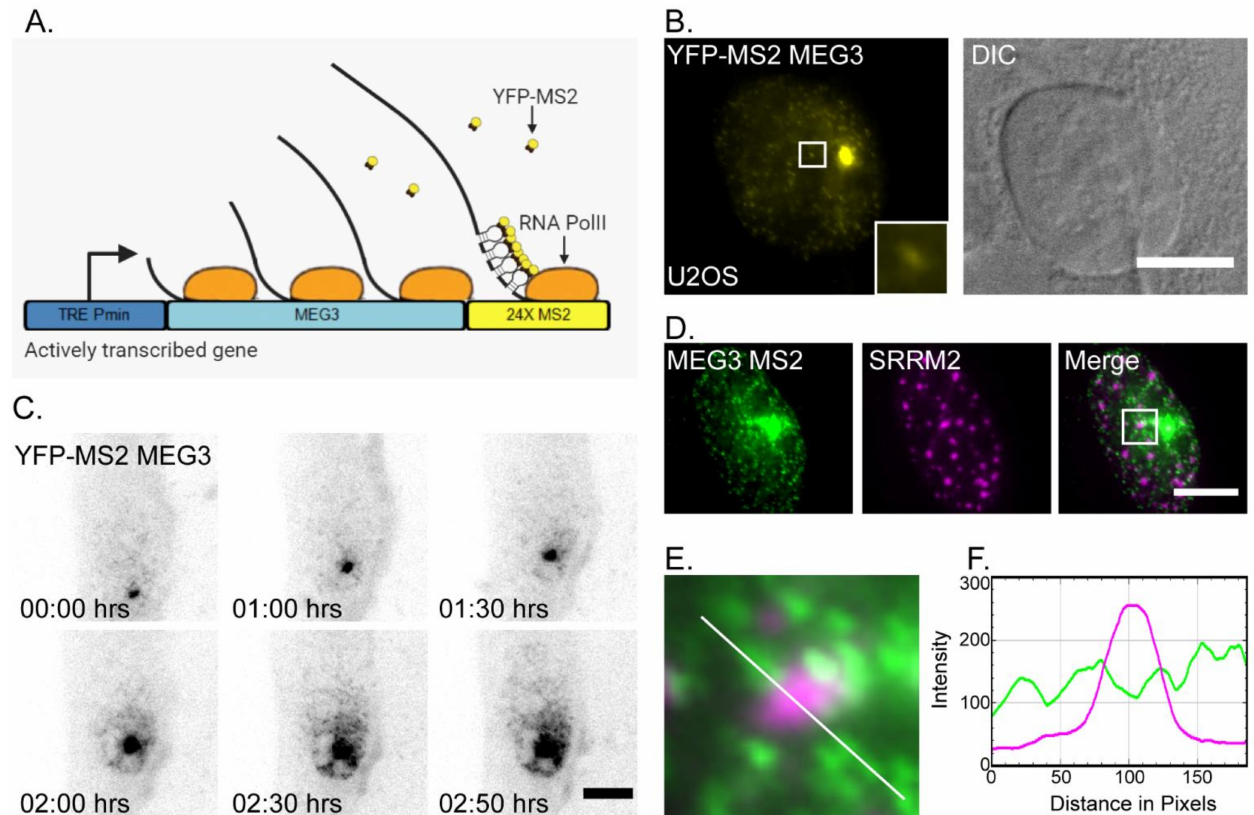
Figure 1. MEG3-MS2 expressed in U2OS cells partially associates with the nuclear speckles. ( A ) Schematic depiction demonstrating the Tet-On MEG3-MS2 expression system. ( B ) U2OS cells stably expressing MEG3-MS2 tagged with YFP-MS2-CP after dox activation (yellow). DIC (grey). The small dots are MEG lncRNPs and the large dot is the active gene. Enlargement of an area with transcripts in the boxed region. Bar = 10 µ m. ( C ) Frames from a live-cell movie (Movie S1) of the transcriptional induction (dox) of MEG3-MS2 expression. The images are an inverted version of the transcript tagged with YFP-MS2-CP (black). Images were captured every 10 min for the duration of 3 h. Bar = 5 µ m. ( D ) MEG3-MS2 tagged with YFP-MS2-CP (green) is partially associated with nuclear speckles stained with an antibody to the SRRM2 nuclear speckle marker (magenta). ( E ) Enlargement of MEG3 and SRRM2 and ( F ) intensity line analysis from the boxed region in D along the white line. Bar = 10 µ